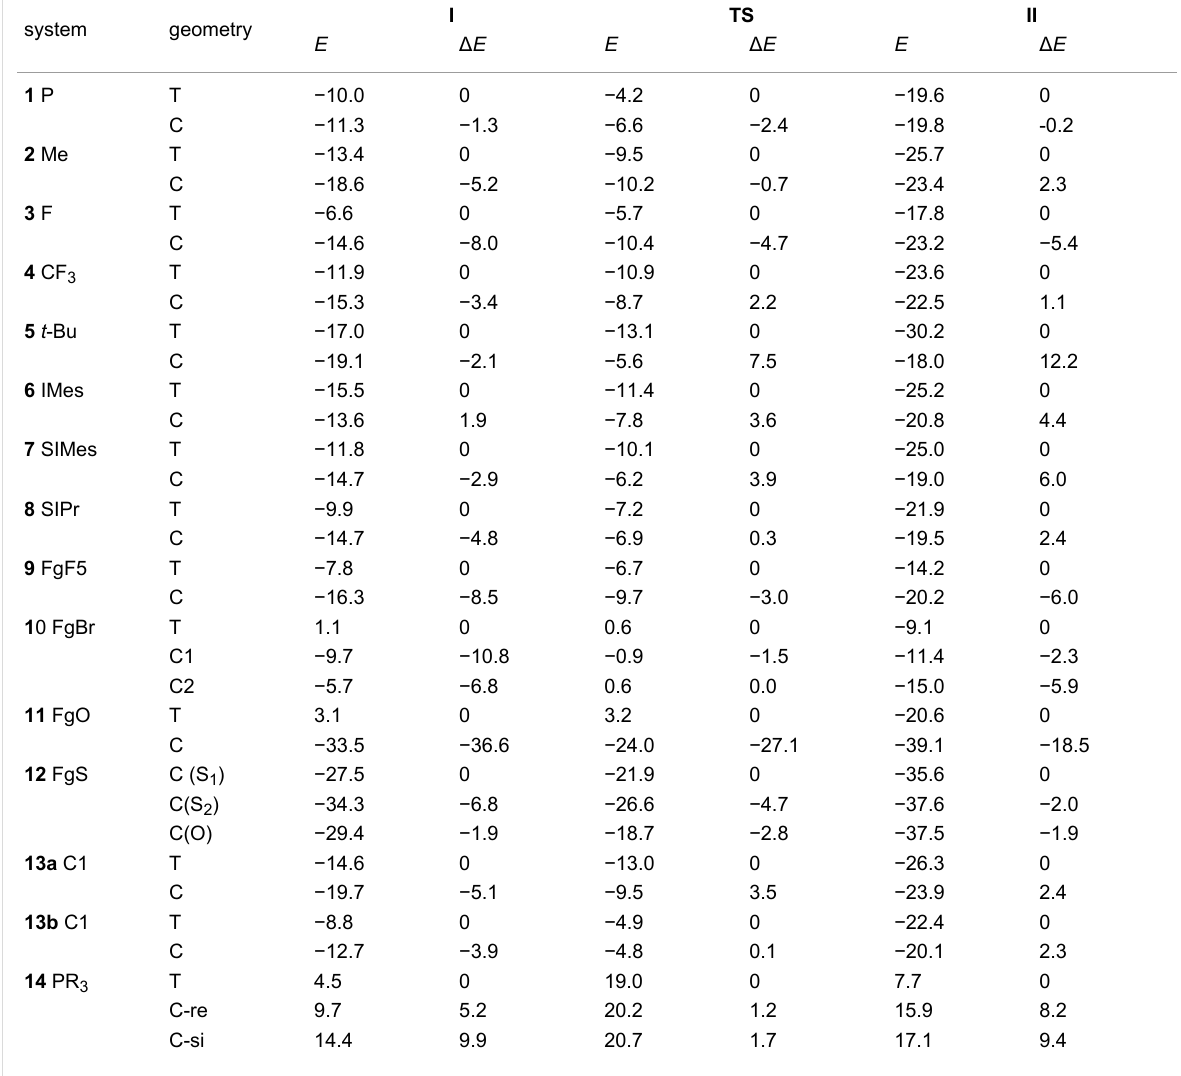
Table 2: Energies ( E) in kcal/mol, of the coordination intermediates, transition states and metallacycles with respect to the 14e species and the unco- ordinated C=C double bond. For each system, the energies of both isomers with the C=C trans or cis to the NHC ligand are reported. For each species, Δ E is the energy difference between the cis and the trans isomer, labeled as C and T, respectively.